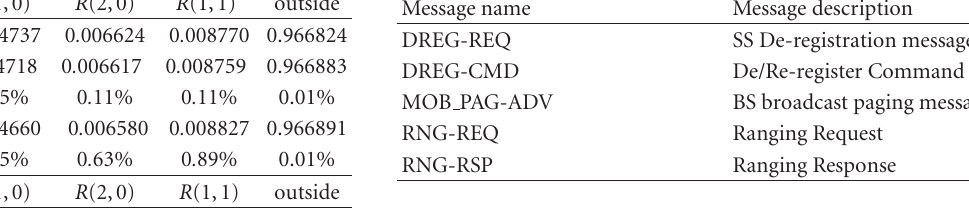
Table 1: The simulation and the math calculation. p = 0 . 8